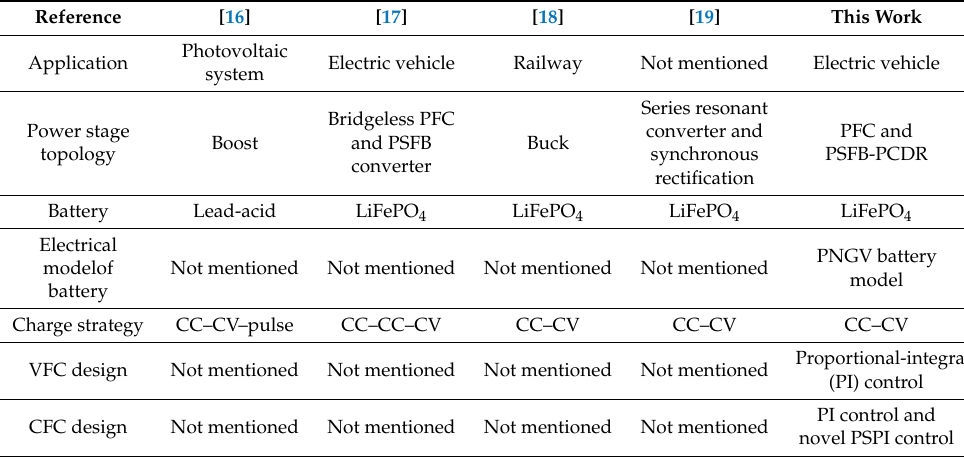
Table 1. Comparisons of power converter topologies and charge